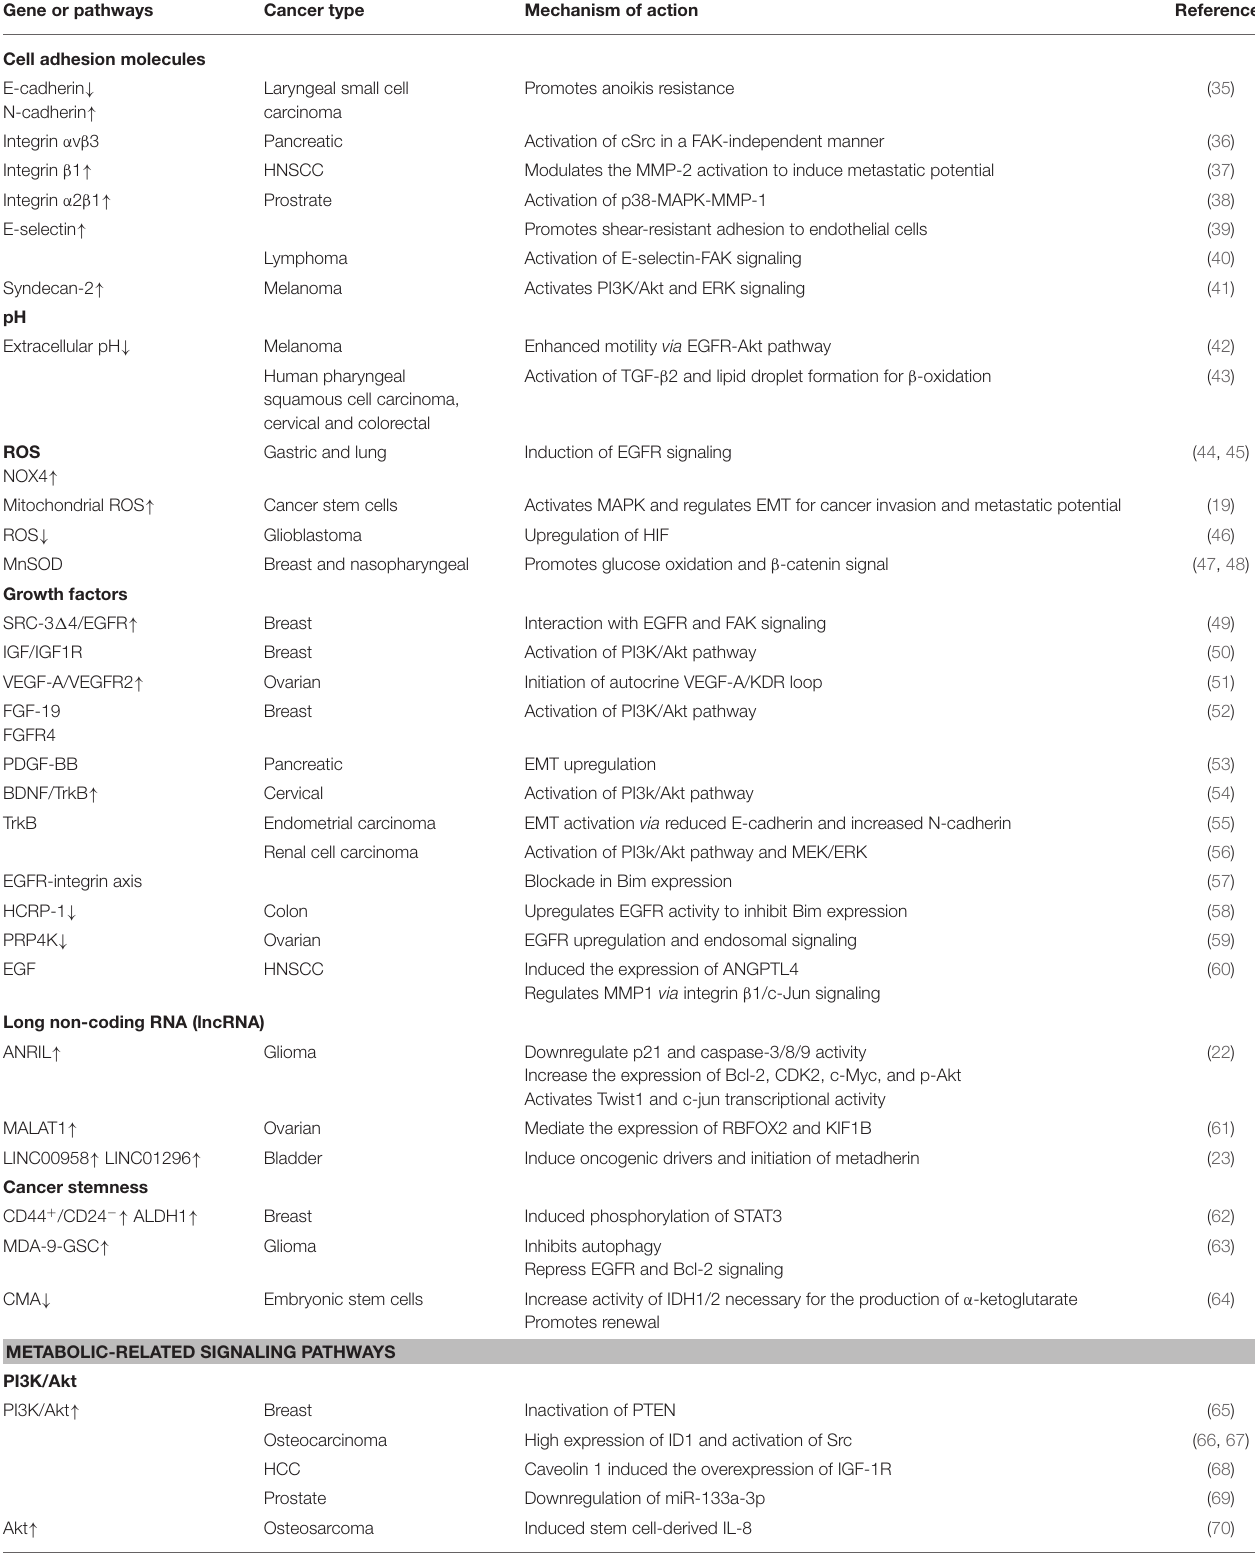
TABLE 1 | Summary of the anoikis-resistance mechanism in cancer